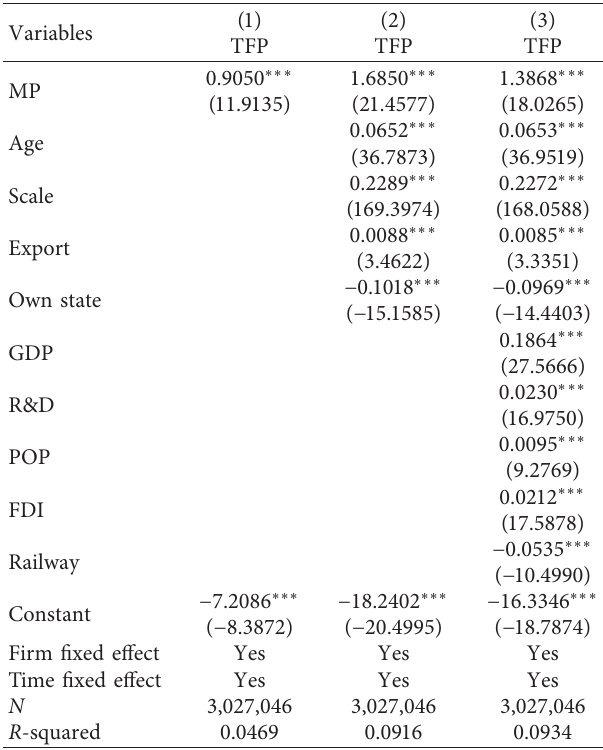
Figure 6: Time trend of highway impact on productivity. Table 10: Result of mechanism test.